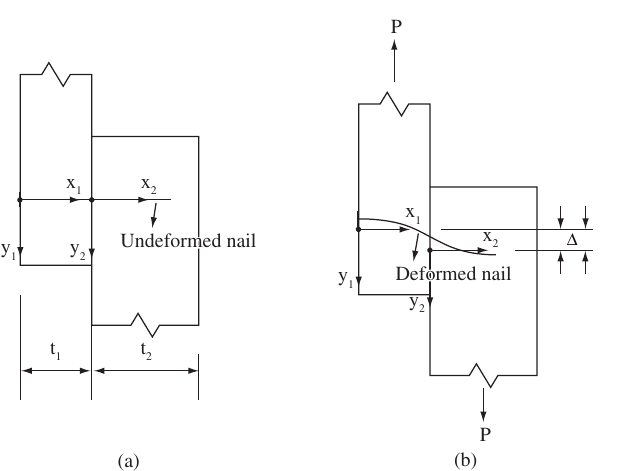
Figure 2. Deformed shape of the connection and convention of axes.